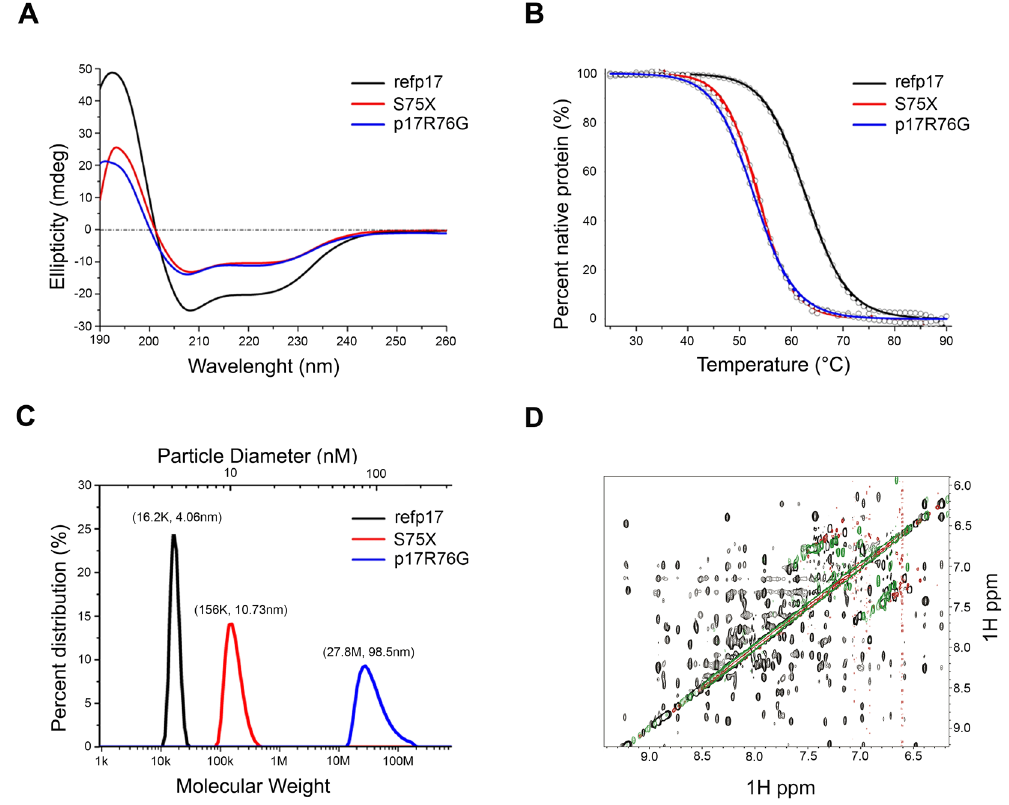
Figure 3. Structure and stability of refp17, S75X and p17R76G. ( A ) CD spectra of refp17, S75X, and p17R76G collected at room temperature at 2.5 μ M in 10 mM phosphate buffer, pH 7.4. ( B ) Thermal denaturation of refp17, S75X, and p17R76G at 10 μ M in PBS, pH 7.4, as monitored at 222 nm by CD spectroscopy. The experimental data were normalized according to a two-state protein denaturation model. Note that the thermal denaturation of p17 is irreversible due to protein aggregation. ( C ) Measurement of the size of folded refp17, S75X and p17R76G viral matrix proteins by the technique of dynamic light scattering at room temperature. ( D ) NMR spectra of refp17 (black), S75X (green), and p17R76G (red) showing their amide-amide NOEs.